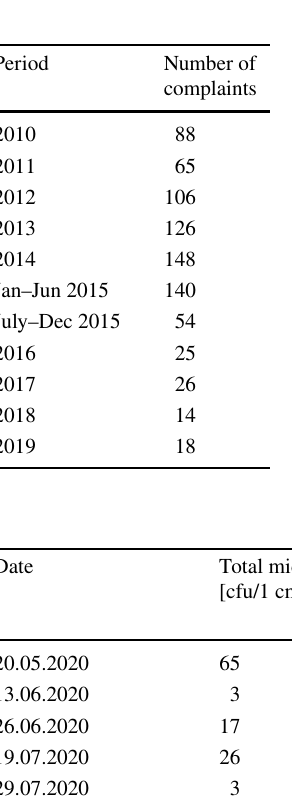
Table 3 Number of substantiated consumer’s complaints - PWSS together with municipalities